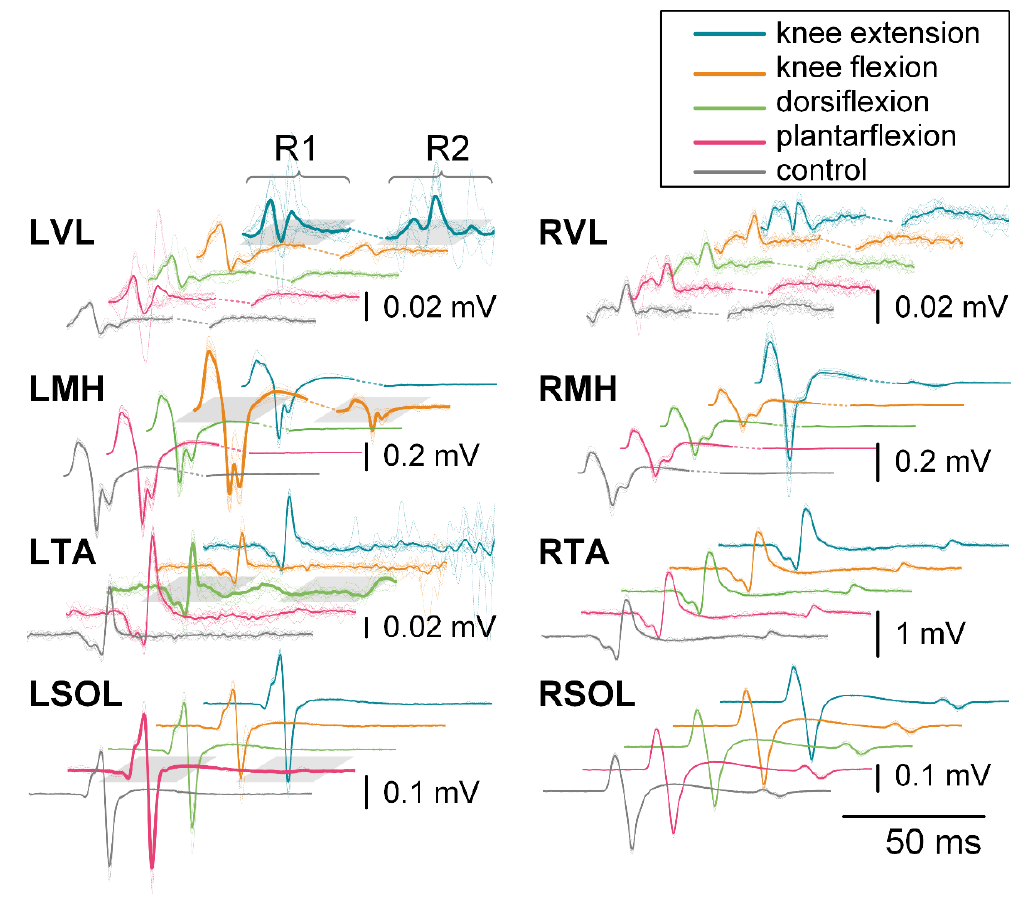
Figure 2. R1 and R2 responses for each muscle during knee extension (blue), knee flexion (orange), dorsiflexion (green), plantarflexion (pink), and control (gray) during the 200 ms CTI auditory condition for a representative participant. Individual responses are traces represented with thin dotted lines, while the average is shown with a thin solid line. The bold line signifies the agonist for that movement. Different amplitude scales are used for each muscle to better visualize the waveforms.